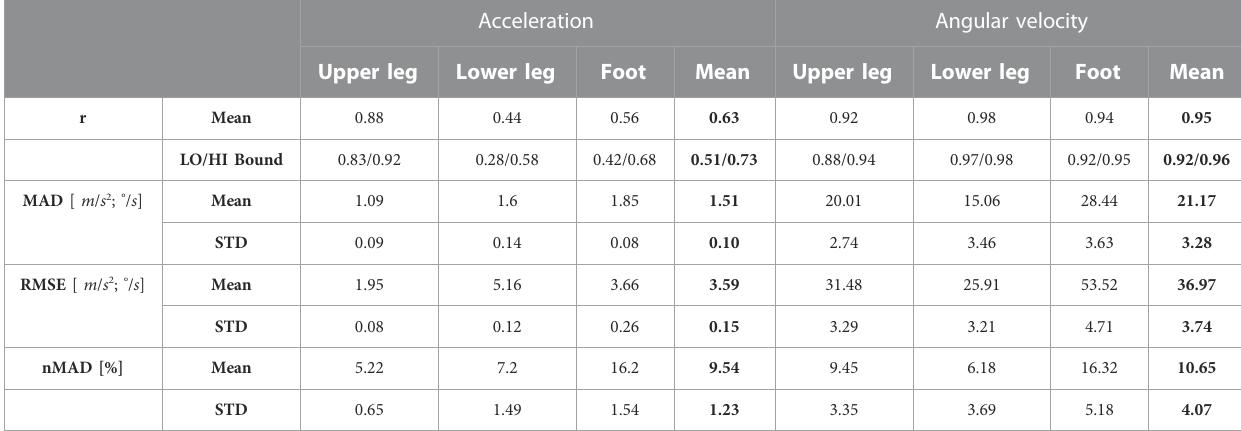
TABLE 1 Pearson correlation coef fi cients r, mean MAD, mean RMSE, mean nMAD, and STD between measured and synthesised sensor timeseries across all participants. LO/HI Bound: Lower and upper bound of 95% con fi dence